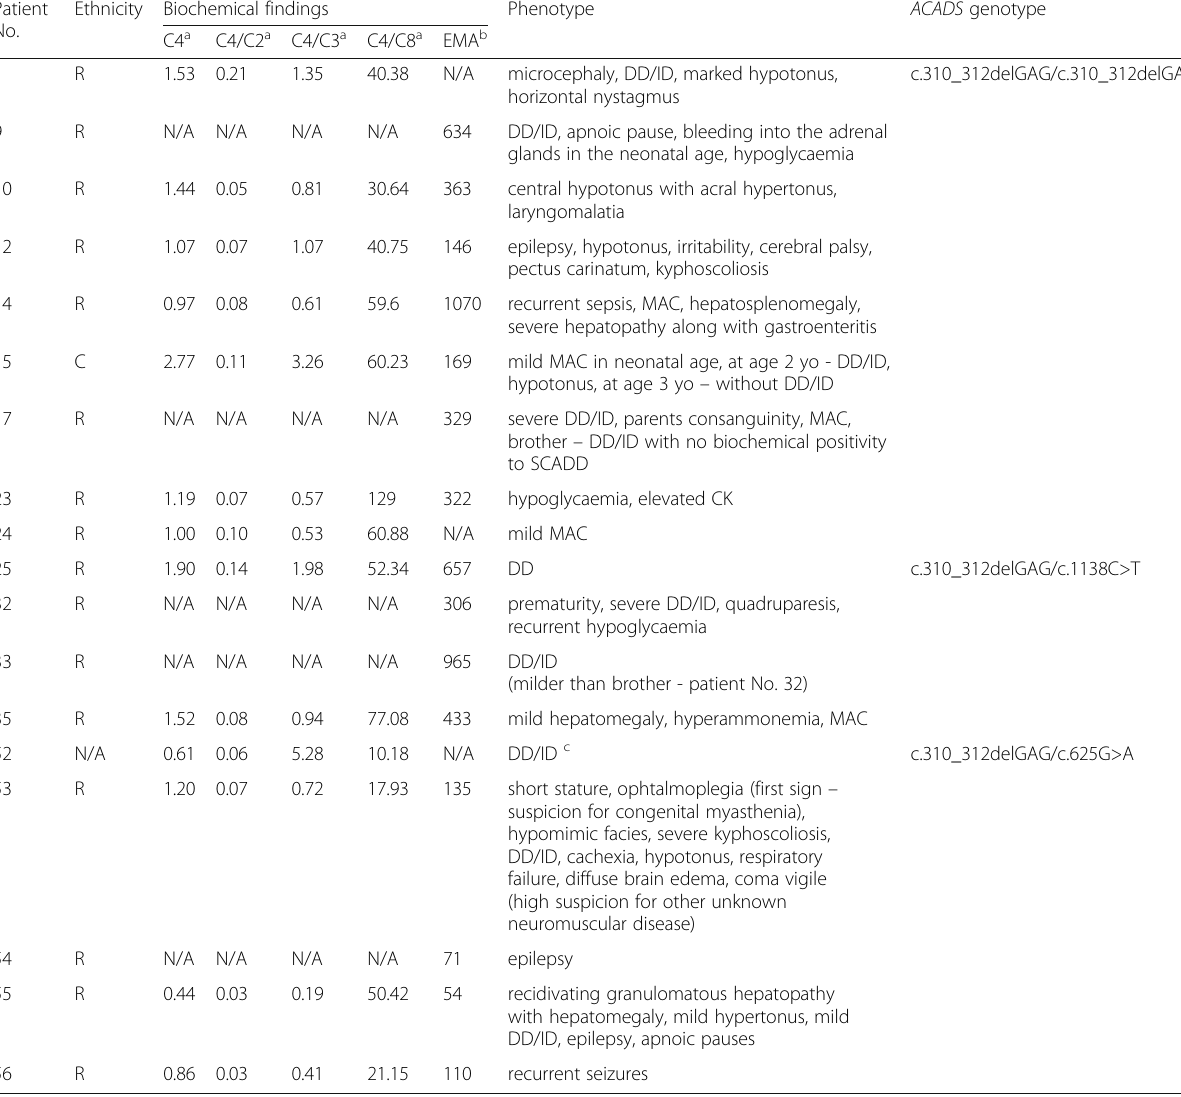
Table 6 Eighteen symptomatic SCAD-deficient patients included in the present study with data concerning ethnicity, biochemical findings, clinical phenotype and ACADS genotype Patient Ethnicity Biochemical No.